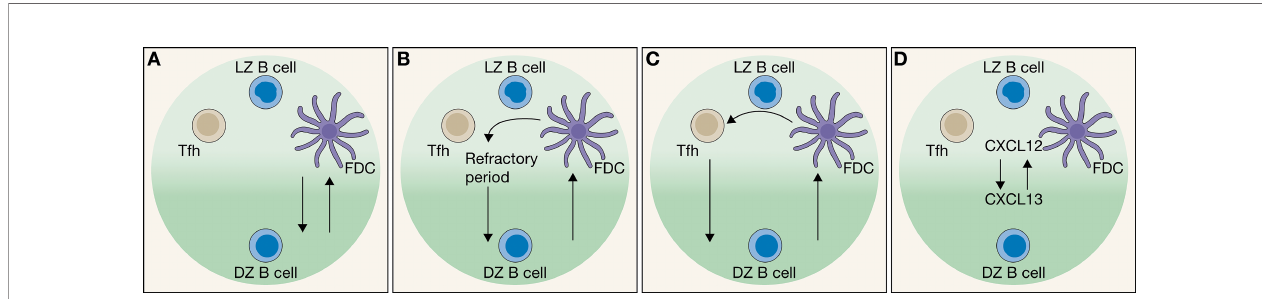
FIGURE 3 | Models of Germinal Center B cell (GCBC) recycling between the light zone (LZ) and the dark zone (DZ). (A) Centrocyte (CC) selection through binding strength of the BCR to an antigen provided by follicular dendritic cells (FDCs). CC then migrates to the DZ and becomes centroblast (CB). Black arrows indicate the GCBC migration. (B) Increase in the refraction rate between CCs and FCDs. (C) Veri fi cation step, where CCs are selected by Tfh cells after a fi rst selection by FDCs. (D) Spontaneous oscillations of GCBC between CXCL12 (representing the LZ) and CXCL13 (representing the